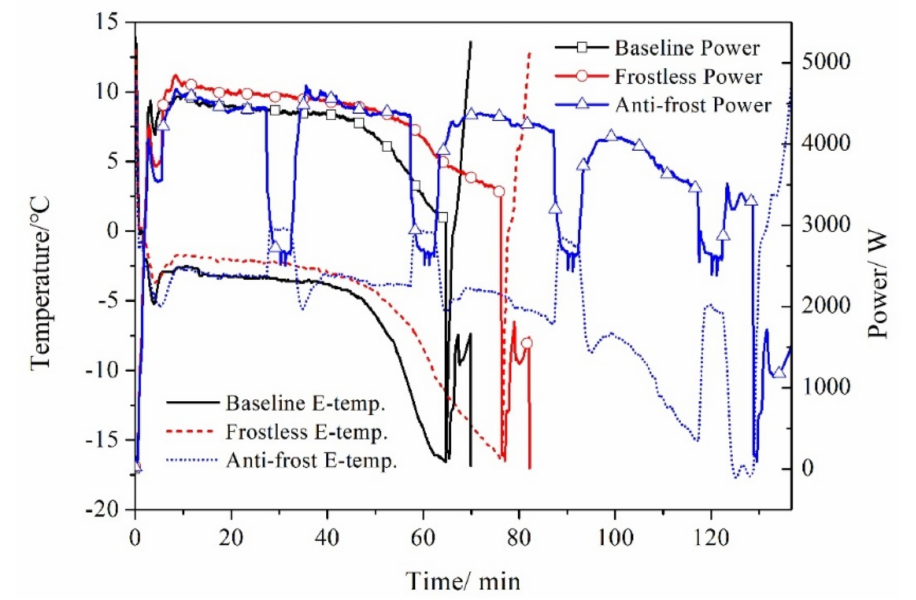
Figure 4. Frosting/defrosting operations of the ASHP in the three